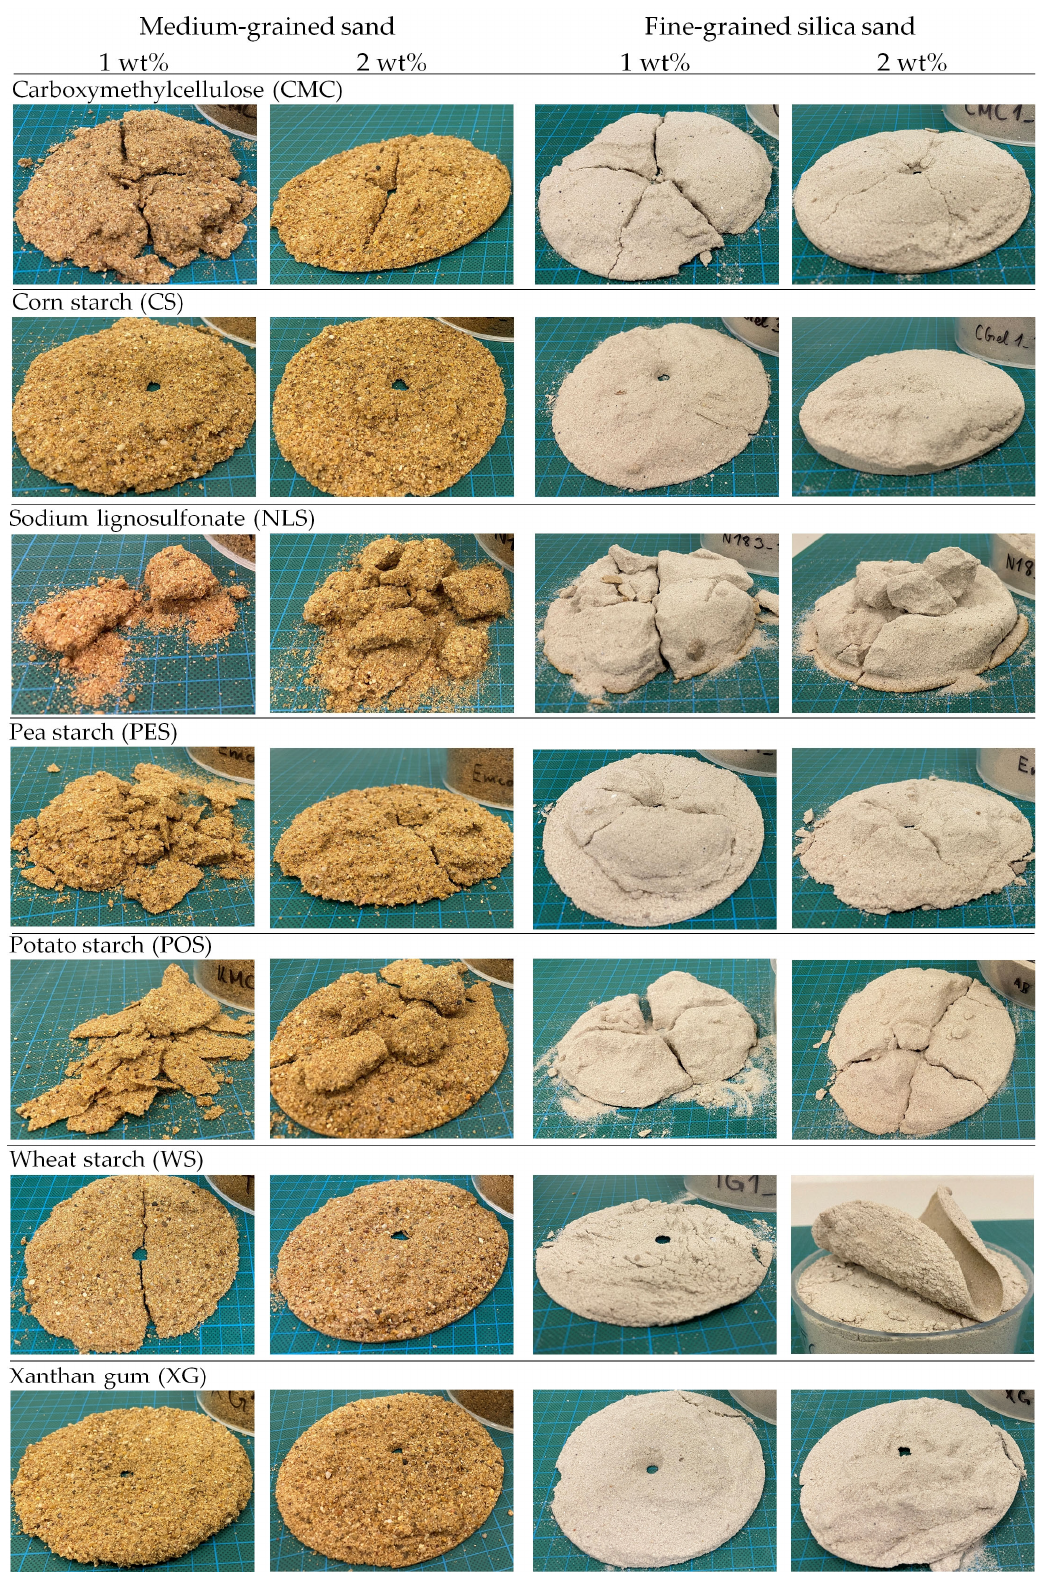
Figure 10. Examples of polysaccharide-induced crusts recovered from the samples (cf. Table A6 for classification).